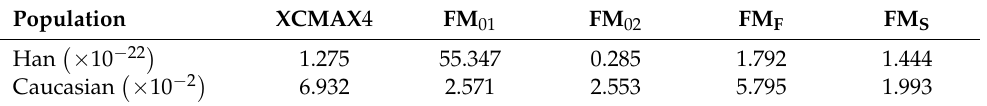
Table 5. p values of XCMAX4, FM 01 , FM 02 , FM F , and FM S tests from Han and Caucasian populations. Population XCMAX 4 FM 01 FM 02 FM F FM